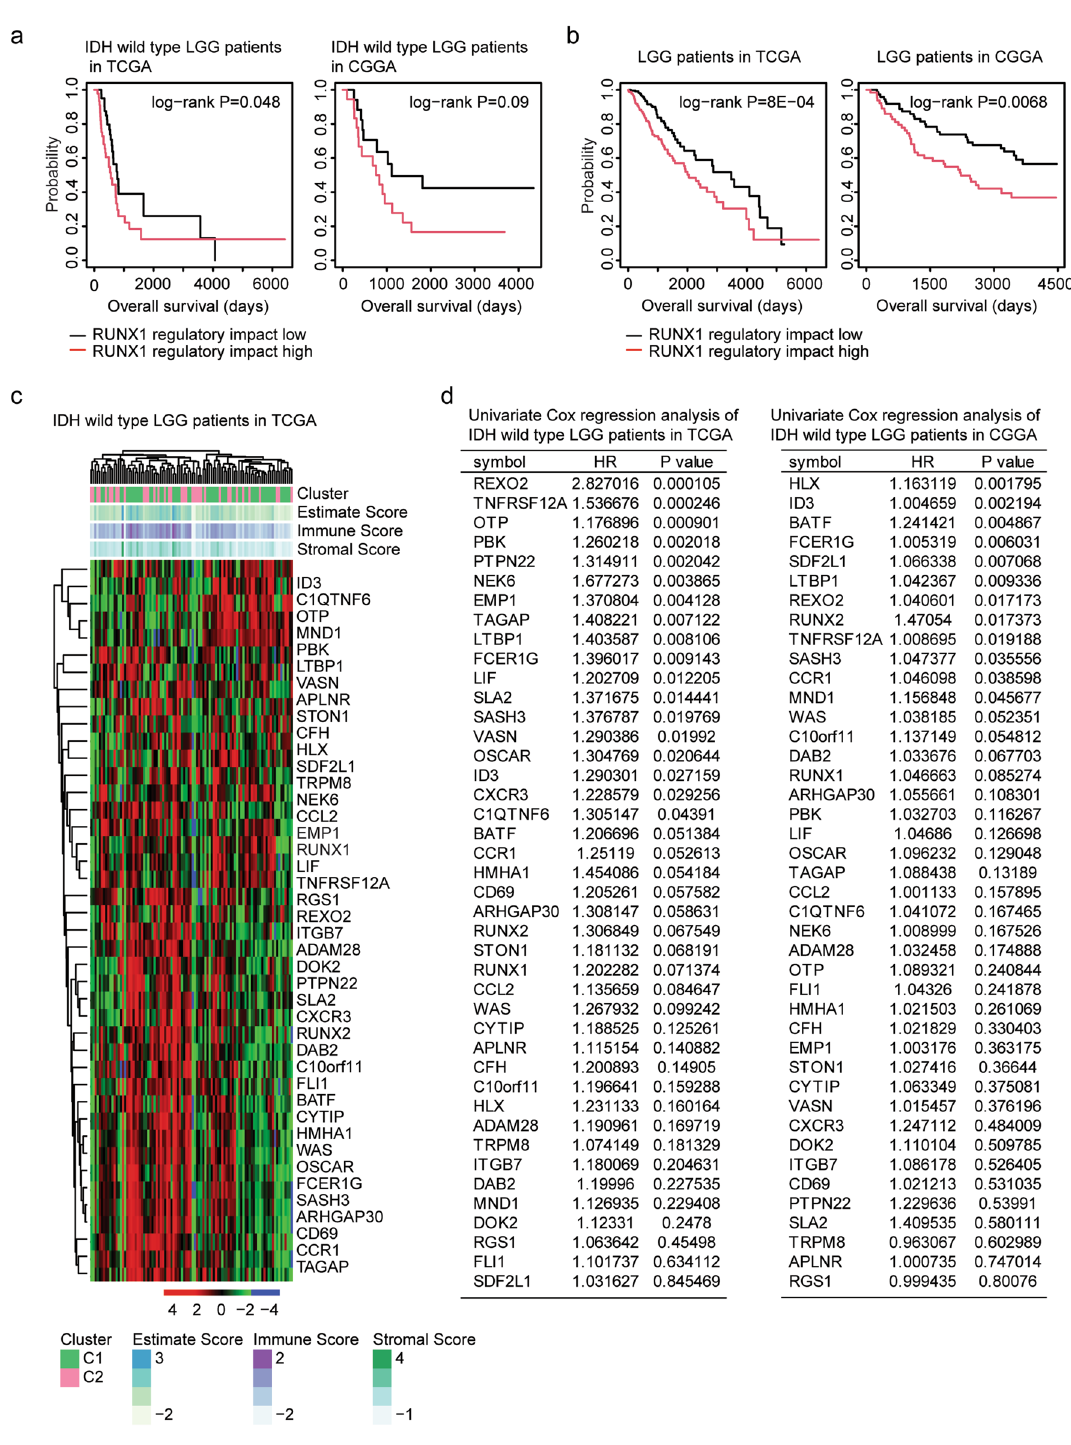
Figure 5. Prognostic significance of RUNX1 target genes. ( a ) The Kaplan–Meier Plotters showed the correlations of the regulatory impact of RUNX1 and overall survival of IDH wild type LGG in TCGA and CGGA datasets. ( b ) The Kaplan–Meier Plotters showed the correlations of the regulatory impact of RUNX1 and overall survival of LGG in TCGA and CGGA datasets. ( c ) Un-supervised clustering heatmaps demonstrated the expression of RUNX1 target genes in IDH wild type LGG patients in TCGA dataset. ( d ) Univariate cox regression analysis showed the prognostic significance of RUNX1 target genes in IDH wild type LGG patients in TCGA and CGGA datasets. HR represented hazard